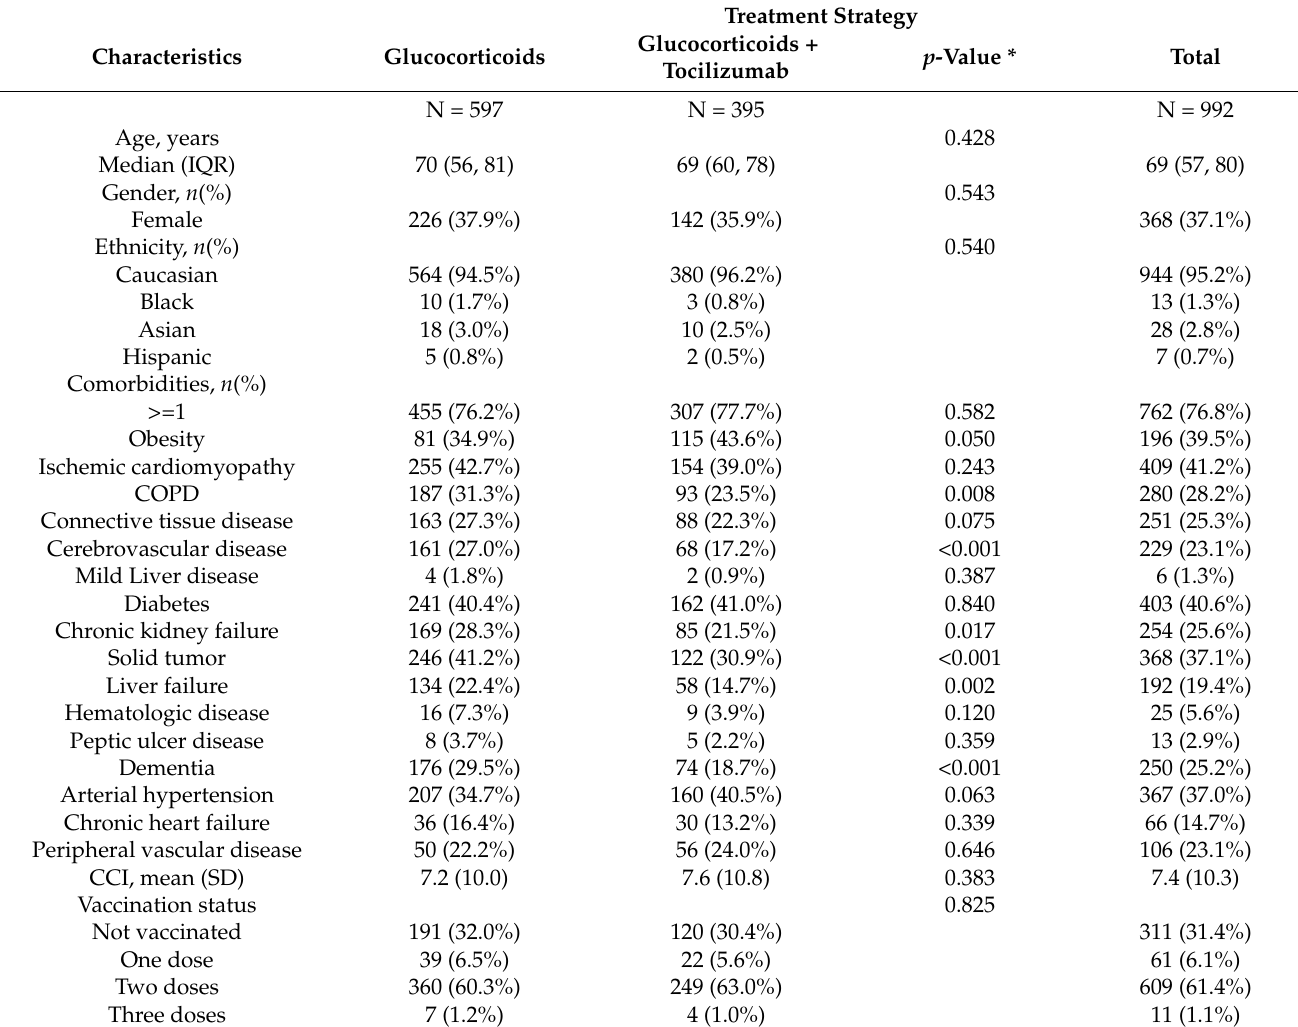
Table 1. Demographics, comorbidities and main delays by treatment